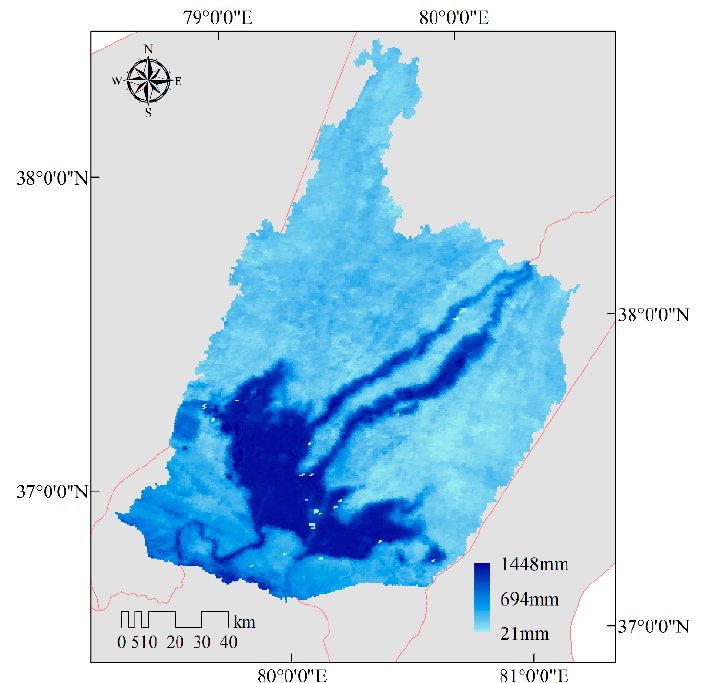
Figure 3. Spatial distribution of evapotranspiration in Hotan Oasis in 2015.